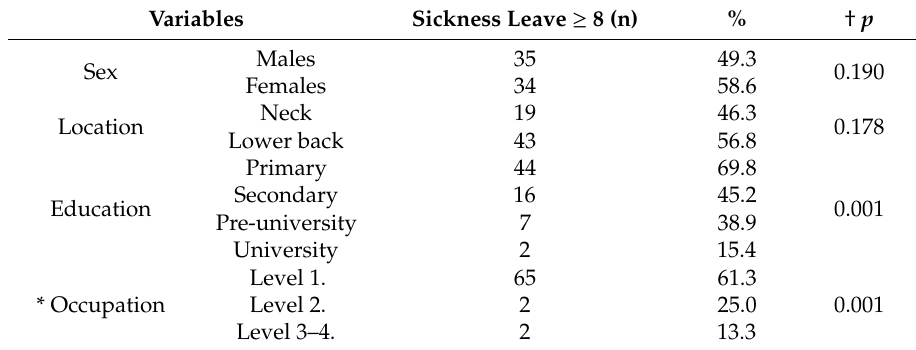
Table A1. Sensitivity analysis with sickness leave greater or equal to eight days. Frequency of sickness leave in each sociodemographic group. † Chi-square